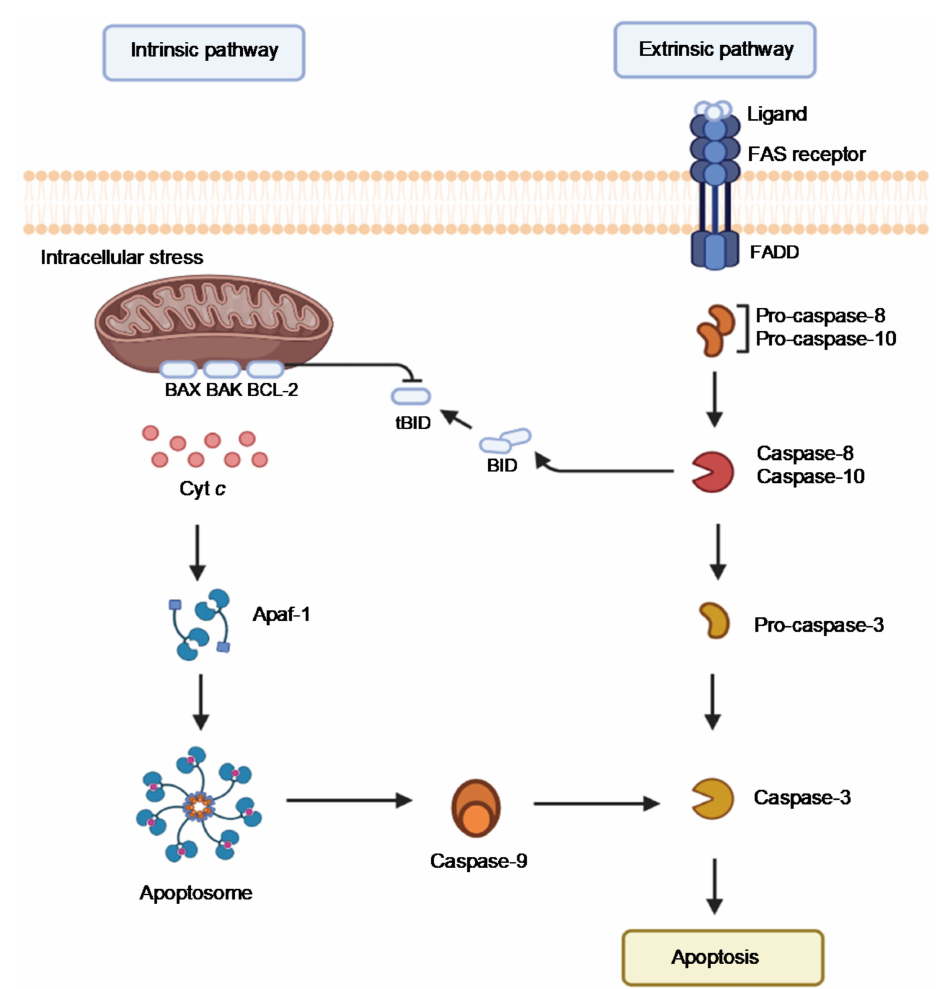
Figure 9. Schematic view of the apoptotic process promoted by the ‘intrinsic’ and the ‘extrinsic’ pathway. (Image was created using